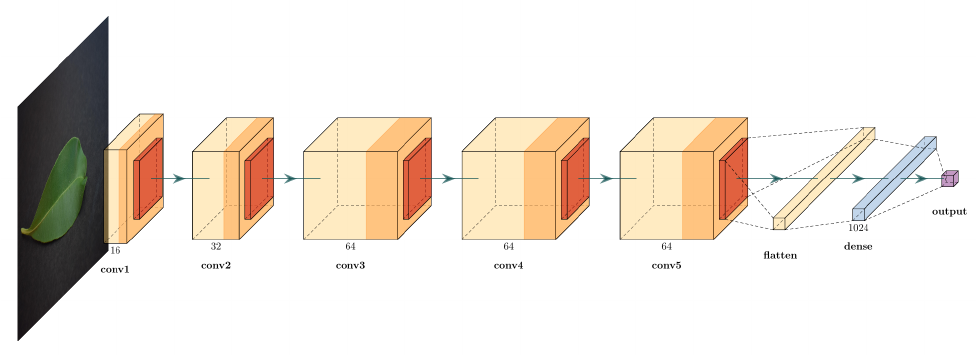
Figure 12. Proposed CNN model. The convolutional layers have 3 × 3 filters, with 2 × 2 pooling. The output is a single value obtained from a sigmoid activation function.